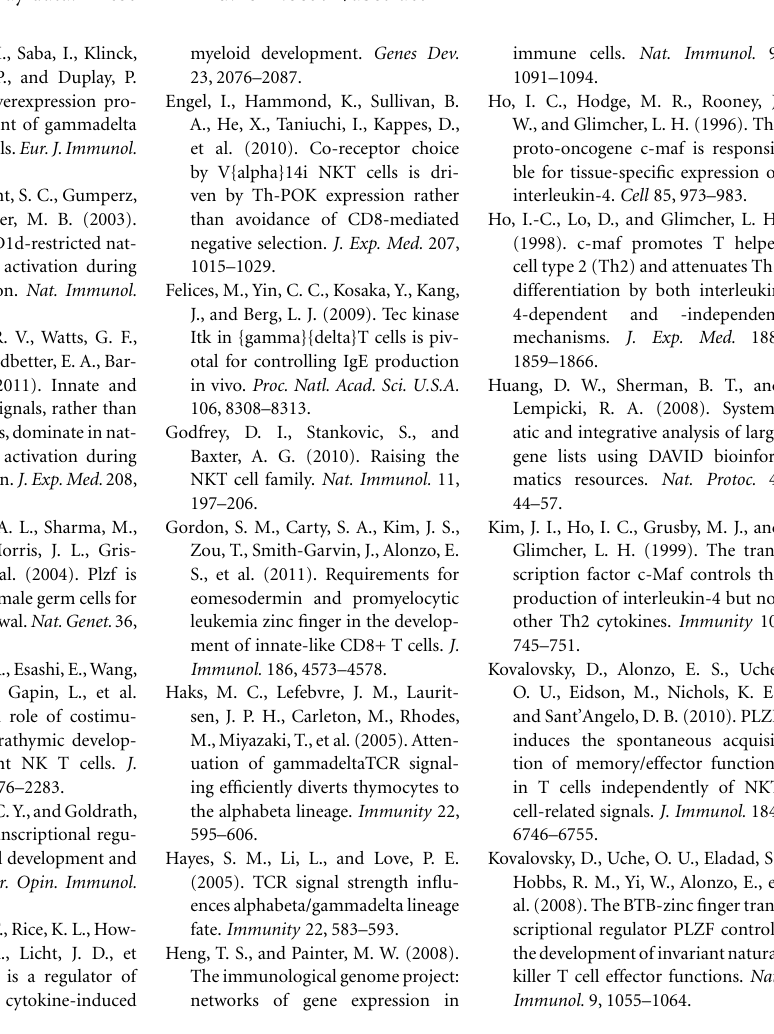
independently). Representative FACS plots from one of three independent experiments are shown. 50,000 sorted CD4 + CD8 − thymocytes from PLZF + / + and PLZF lu/lu Rag1 − / − V γ 1V δ 6.4TCR transgenic animals (C) or 4000 sorted thymic iNKT cells (TCR β + CD1d-Tet + ) from wt and PLZF lu/lu mice (D) were stimulated with IL12 and IL18 for 48h or left unstimulated. Production of IFN γ was measured by ELISA. (E) CD25 expression by wt and PLZF-deficient cells in response to IL-12 or anti-CD3